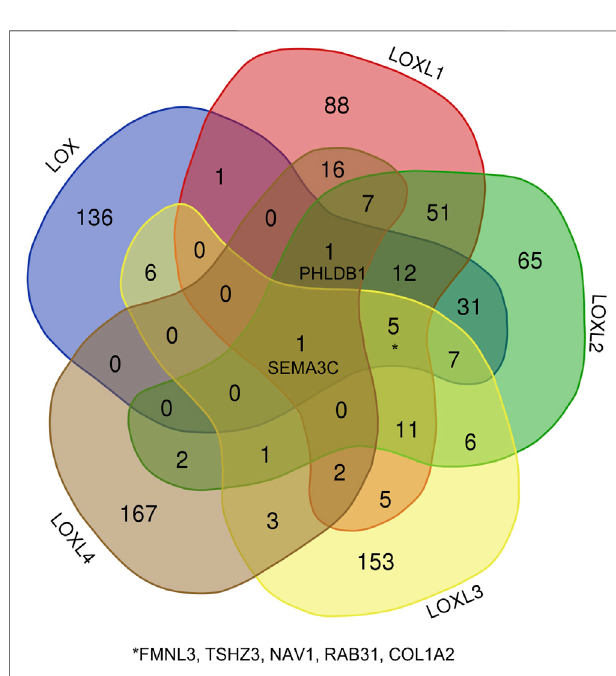
Frontiers in Molecular Biosciences |